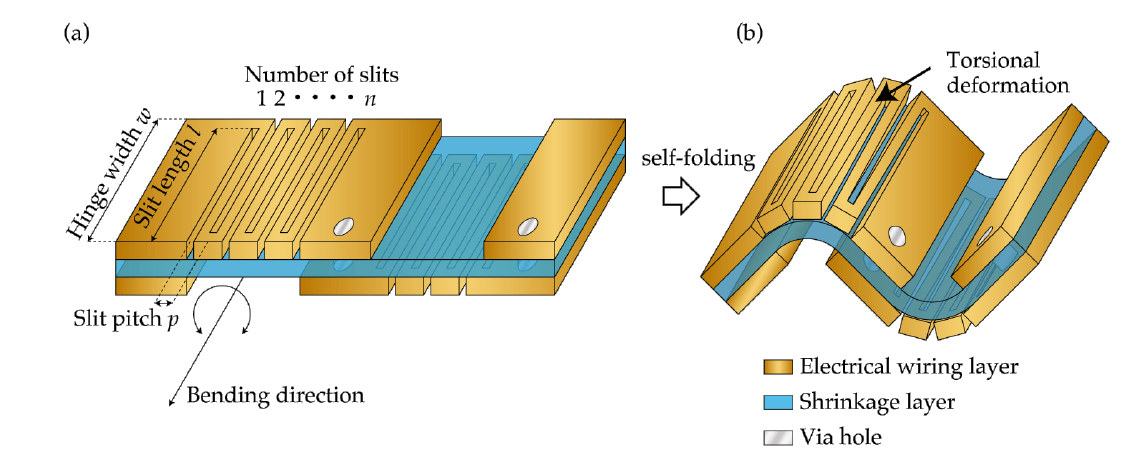
Figure 1. Schematic illustrations of the self-folding method for hinged origami/kirigami stretchable electronic device; ( a ) Structure before folding; ( b ) Structure after folding.